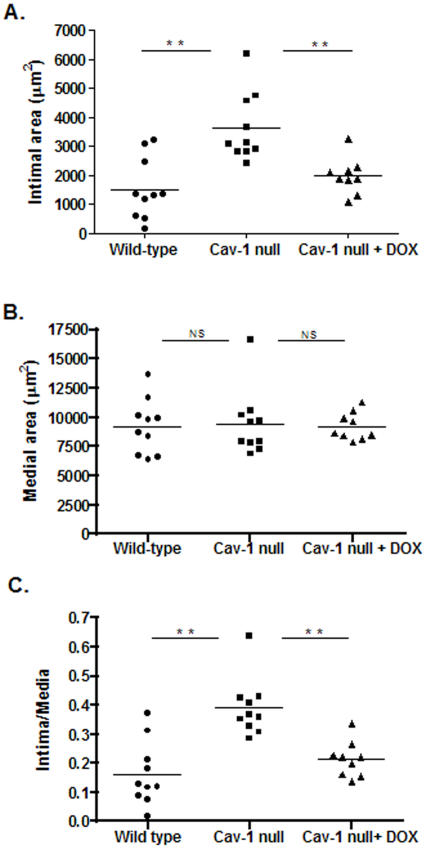
Morphometric analysis of cuffed femoral arteries.Total intimal area (A), medial area (B) and intima-media ratio (C) were quantified by image analysis using 6 serial sections in each cuffed artery. WT (n = 11) values are represented by circles, Cav-1 null (n = 10) are shown as squares and Cav-1 null+DOX (n = 9) are indicate as triangles, ** p<0.001.